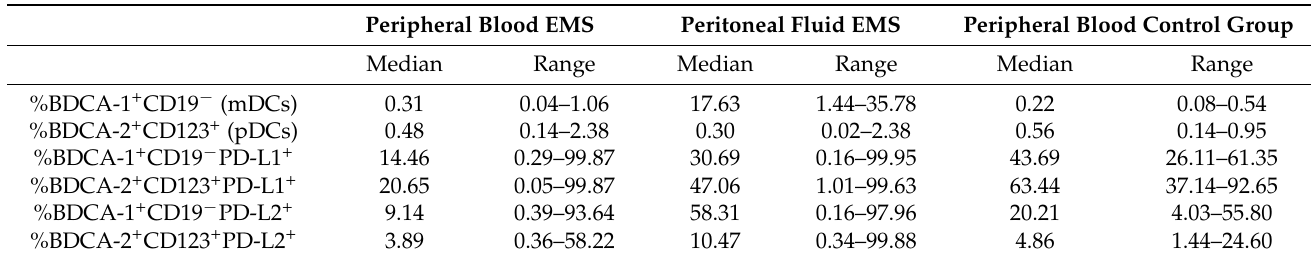
Table 1. Percentage of PD-L1- and PD-L2-positive dendritic cells in patients with endometriosis and the control group.